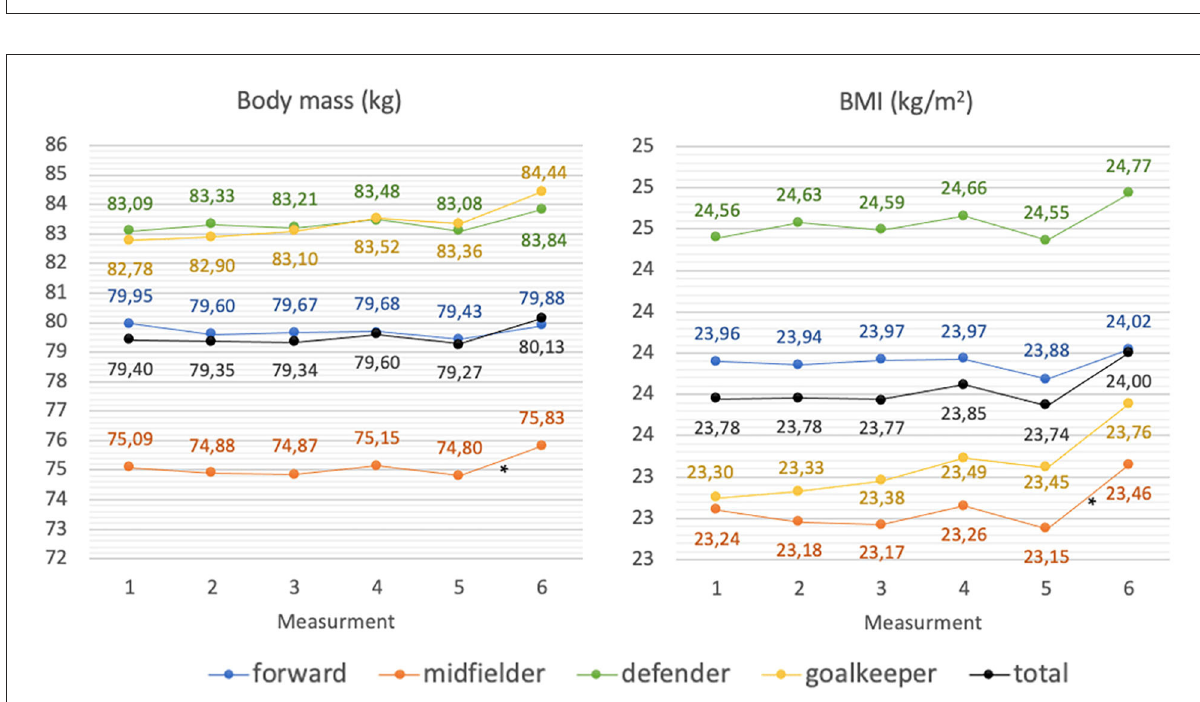
FIGURE3 Changes in body mass, and BMI of football players during the spring round of the 2020/2021 football season (average values); *significantly different from ( p <